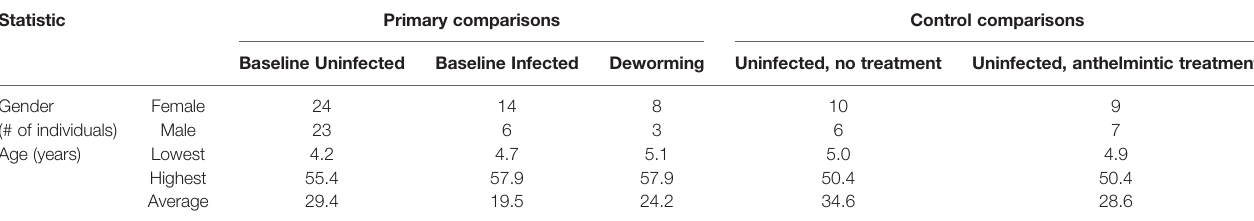
TABLE 1 | Gender and age metadata summary for human samples used in each comparison.